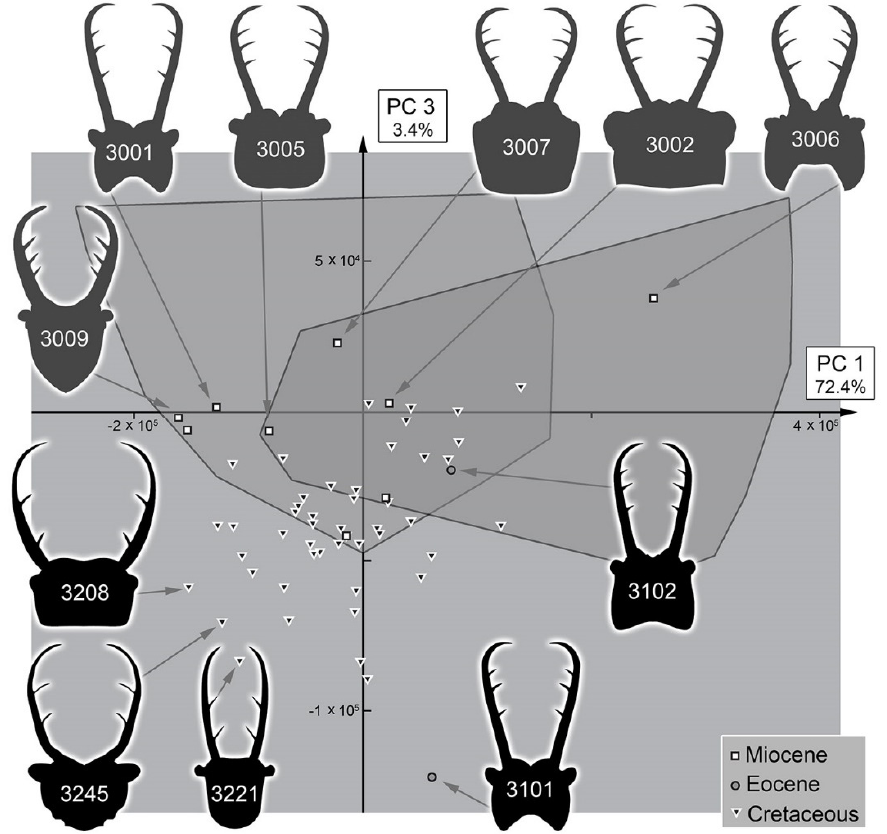
Figure 40. Scatterplot of PC3 vs. PC1 values of head shapes of fossil specimens. Extant specimens only shown as an occupied area to highlight the position of fossil specimens. Black heads = Cretaceous and Eocene larvae; grey heads = Miocene larvae.